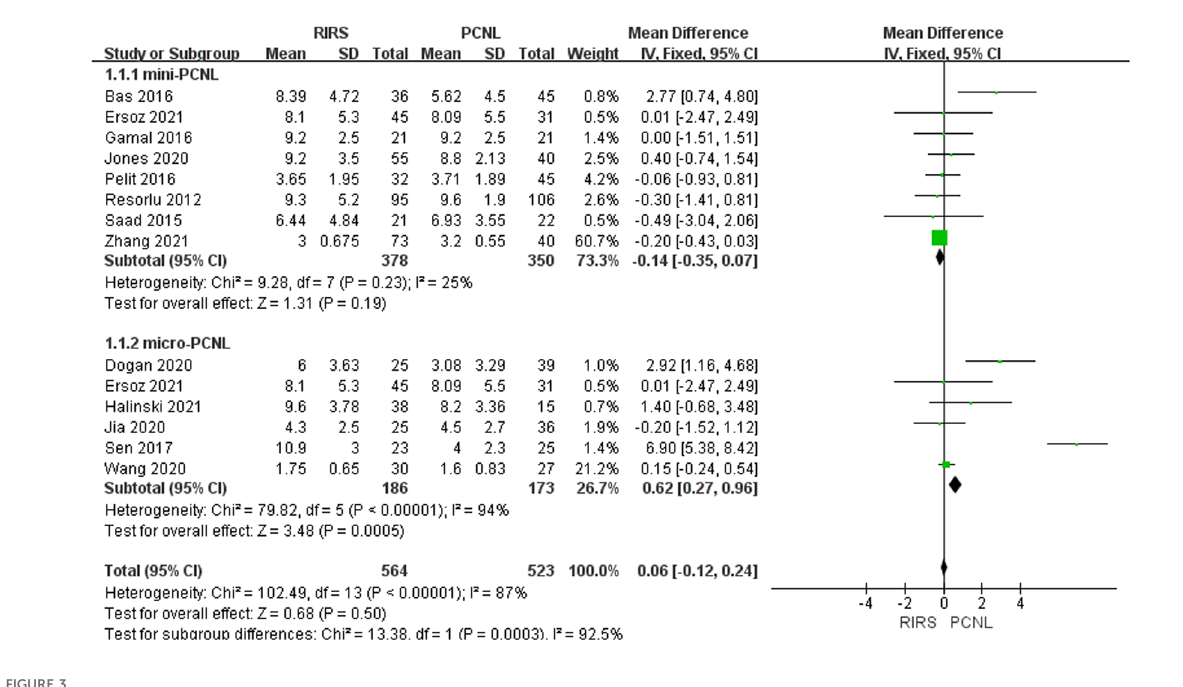
FIGURE 3 Forest plot of age between the RIRS group and the PCNL